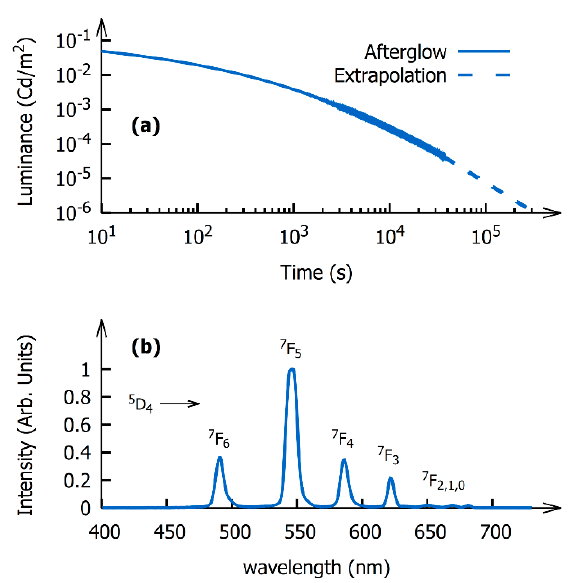
Figure 3. ( a ) Afterglow curve of the polymer layer containing the Na(Gd,Lu)F 4 :Tb 3 + nanoparticles; ( b ) normalized radioluminescence spectrum of the Na(Gd,Lu)F 4 :Tb 3 + nanoparticles.